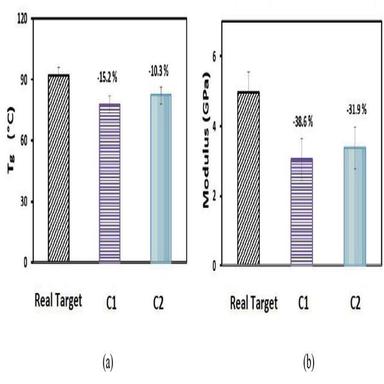
(a) Glass transition temperature (Tg) and (b) storage modulus of both C1 and C2 composites with comparing with that of a real UAV.